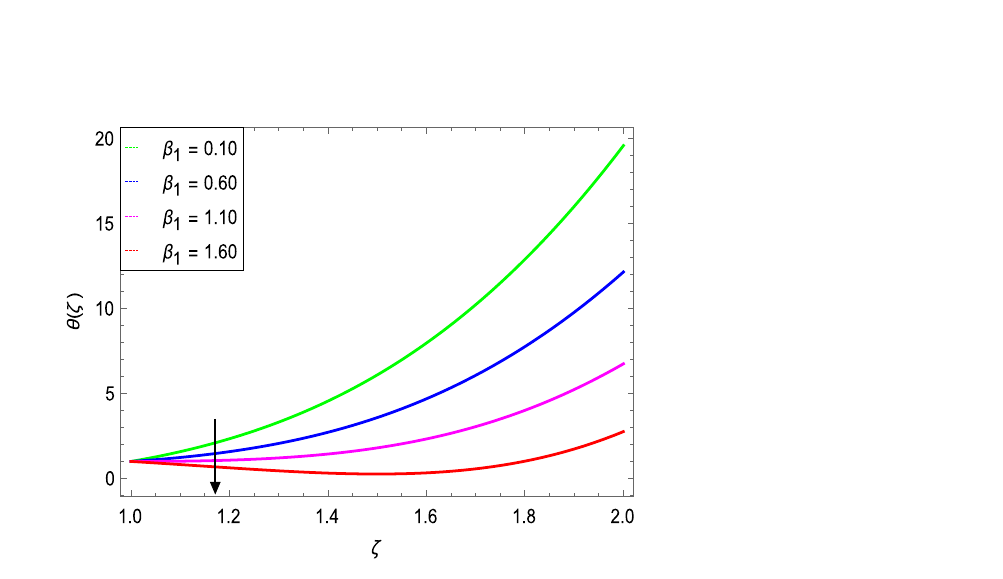
Figure 13. θ (ζ) as a function of β